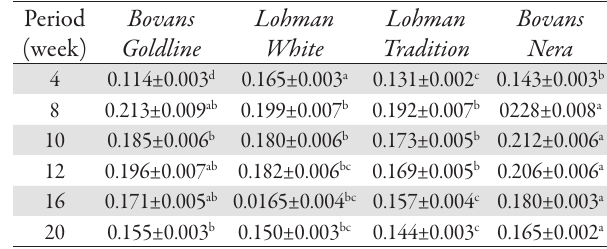
Tab. 2. Feed conversion ratio of growing pullet strains of birds fed the same diet